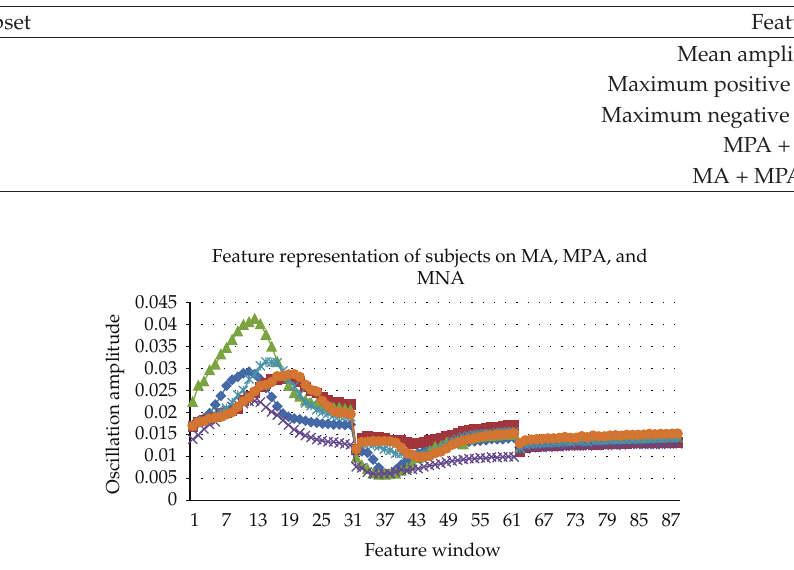
Table 2: Subsets of features extracted using the oscillometric method.